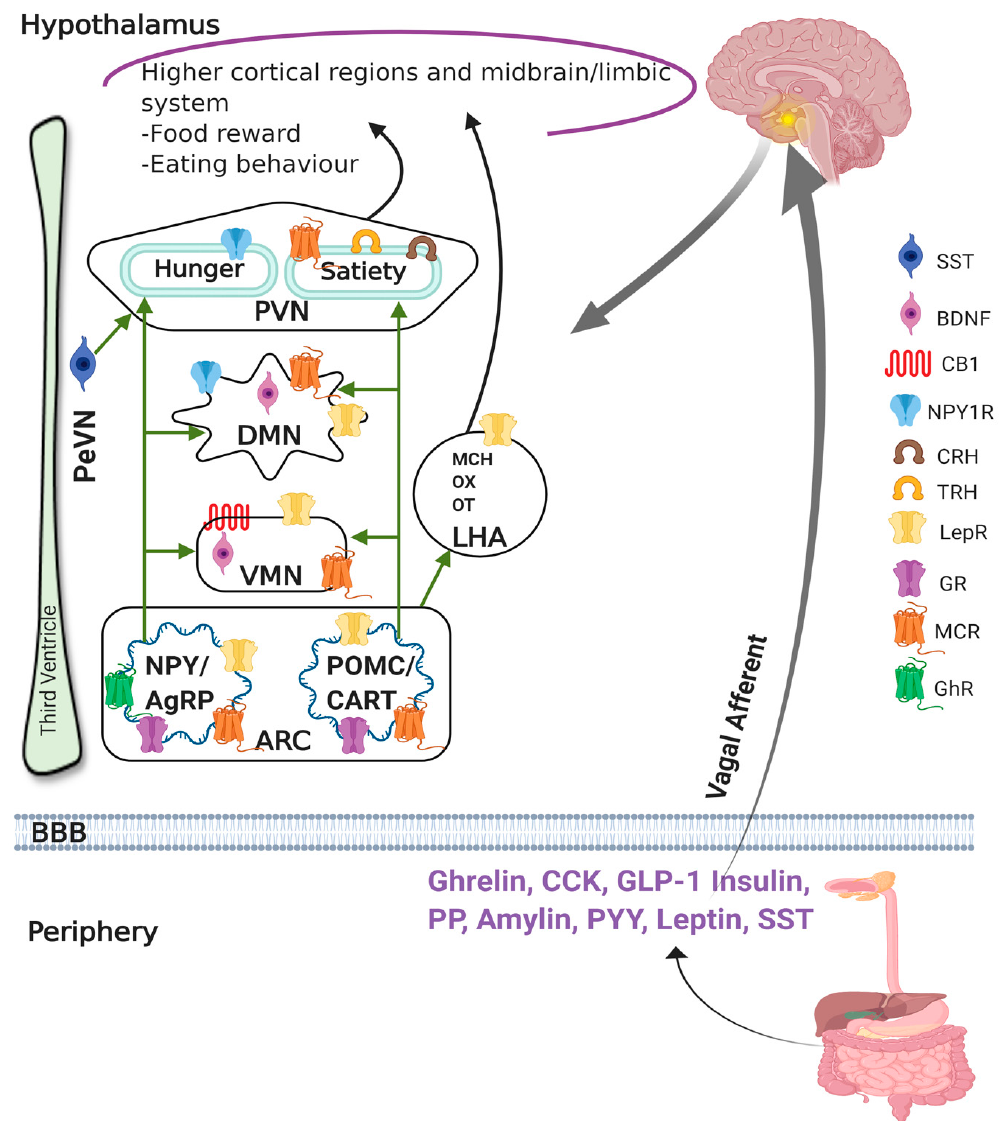
Figure 4. Schematic illustration of hypothalamic regions and peripheral hormones in regulation appetite and satiety. NPY / AgRP and POMC / CART neurons in the ARC project to second-order neurons in other hypothalamic nuclei, including the PVN, DMN, VMN, and LHA. These second-order hypothalamic neurons express anorexigenic neuropeptides (CRH, TRH, OT, and BDNF) and orexigenic neuropeptides (OX and MCH), which regulate appetite and modulate energy homeostasis. In addition, the regulation of energy balance involves an integration of signaling from the hypothalamus, brain stem, and reward pathways of the mesolimbic system. SST acts via hypothalamic nuclei and pancreas. Leptin acts directly on the NTS as well as hypothalamic nuclei, and it can modulate appetite through di ff erent pathways. Green arrows indicate activations within hypothalamus; Black arrows indicate activations other than hypothalamus. ARC, arcuate nucleus; AgRP, agouti related peptide; BDNF, brain-derived neurotrophic factor; CART, cocaine- and amphetamine-regulated transcript; CB1, cannabinoid receptor 1; CCK, cholecystokinin; CRH, corticotropin, releasing hormone; DMN, dorsomedial nucleus; GhR, ghrelin receptor; GLP-1, glucagon like peptide-1; GR, glucocorticoid receptor; POMC, propiomelanocortin; PYY, peptide YY; IRN, insulin receptor neuron; LHA, lateral hypothalamic area; LepR, leptin receptor; MCH, melanin-concentrating hormone; MCR, melanin-concentrating hormone receptor; NTS, nucleus of the tractus solitaries; NPY, neuropeptide Y; OT, oxytocin; PeVN, periventicular nucleus; PVN, paraventicular nucleus; SST, somatostatin; TRH, thyrotropin-releasing hormone; VMN, ventromedial nucleus. Created with paid subscription of